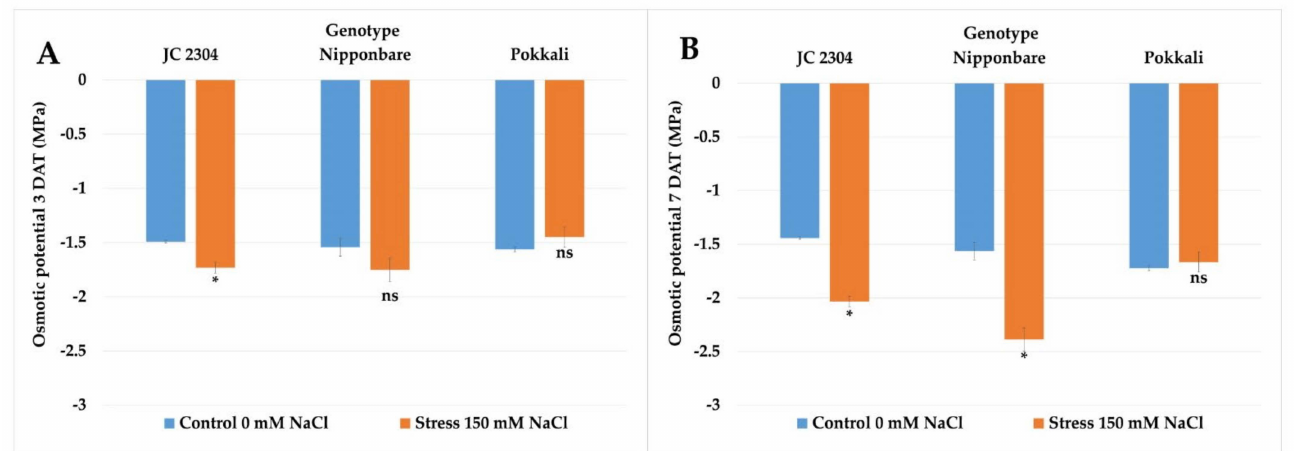
Figure 5. Effects of 150 mM NaCl on the osmotic potential of seedlings of wild and cultivated rice. ( A ) Osmotic potential 3 DAT. ( B ) Osmotic potential 7 DAT. Data represent means ± SE ( n = 3). Asterisks indicate the significant difference of salt-stressed plants with respect to non-stressed plants, based on the Student t -test (ns-not significant, * p ≤ 0.05). DAT—day after